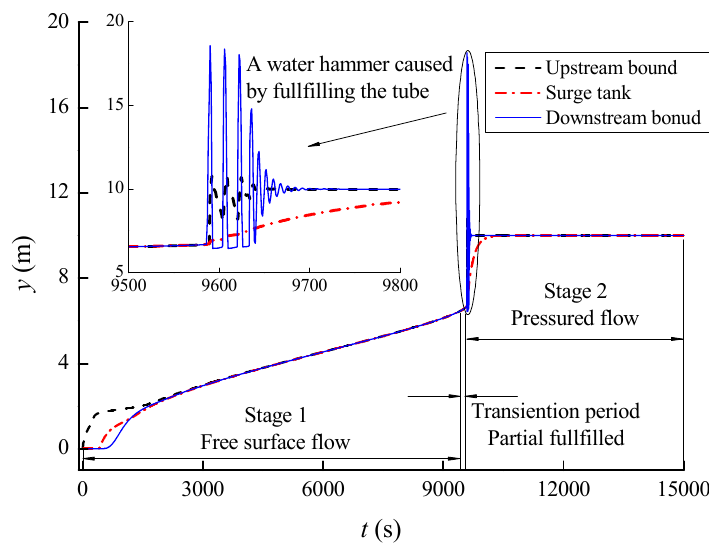
Figure 16. Water level at specific points in the entire water filling process.